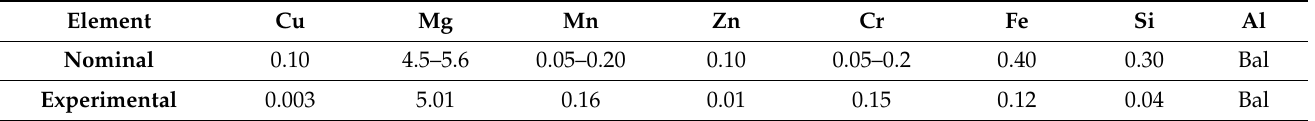
Table 1. Mass fraction of 5056 aluminum alloy